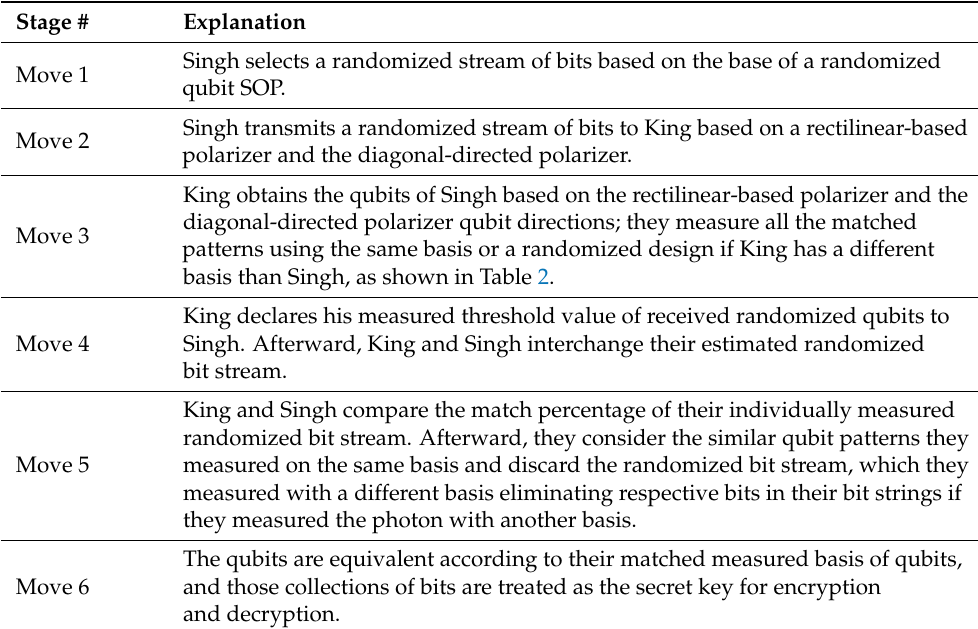
Table 4. The BB84 QKD design standard.